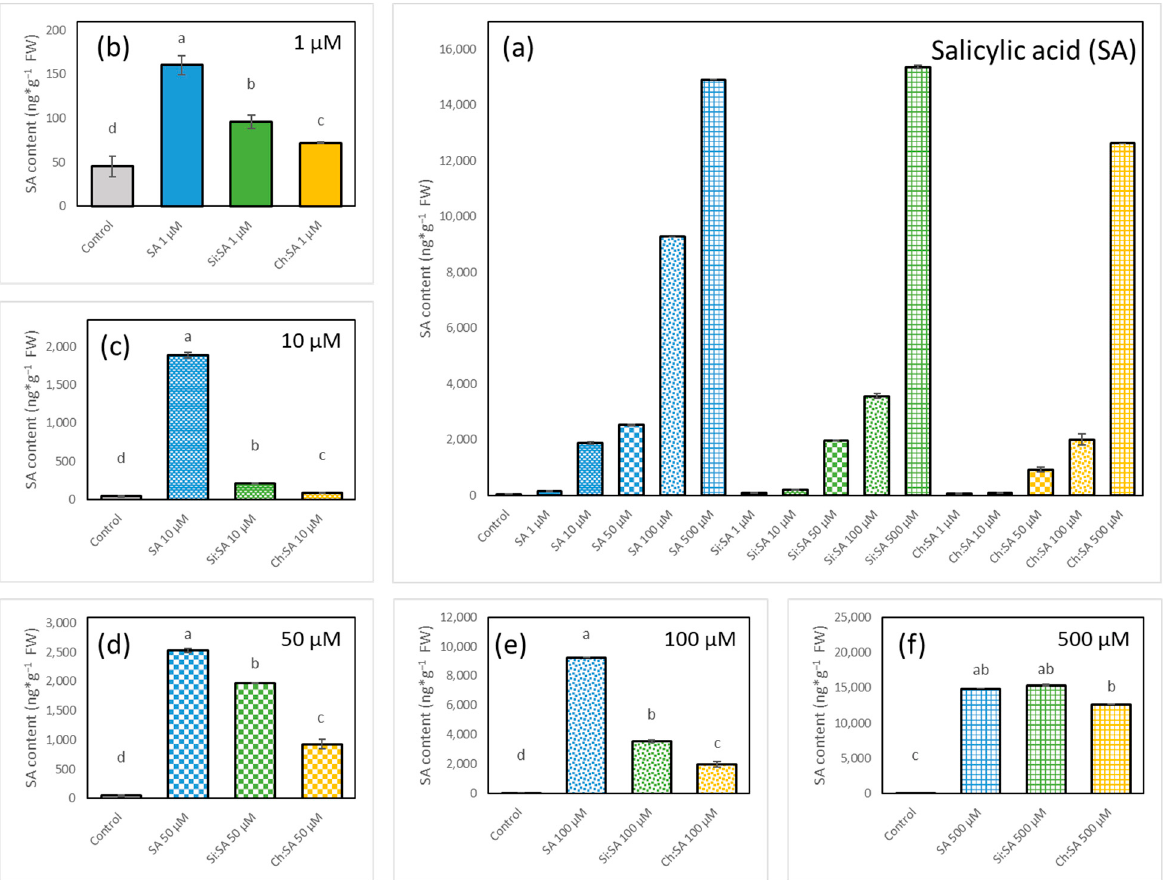
Figure 8. Effect of free SA, Si:SA and Ch:SA on endogenous SA levels in the roots of Col-0 Arabidop- sis plants. Five-day-old plants were transferred to media containing different SA treatments and plant hormones were measured 28 days later. Graph ( a ) depicts SA levels in the three treatments at all doses, and graphs ( b – f ) compare SA levels among the treatments at each dose. Different letters indicate significant differences among treatment groups at p ≤ 0.05.